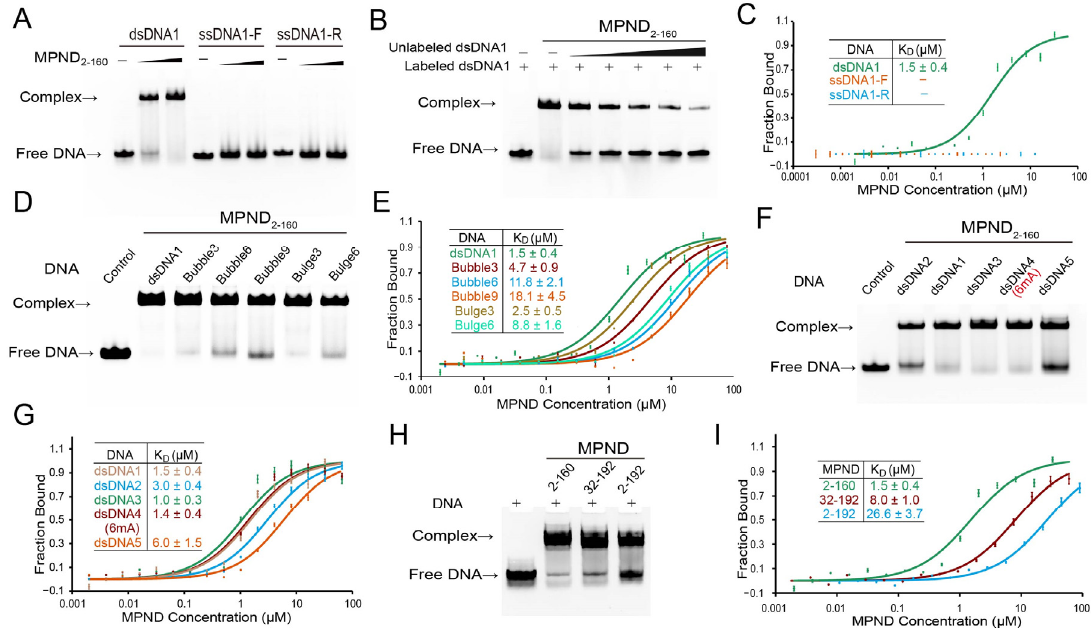
Figure 2. The binding of MPND to dsDNA. ( A ) The EMSA of MPND with dsDNA and ssDNA. Arrows indicate the positions of free DNA or protein-binding DNA. ( B ) EMSA showed that the binding of MPND with FAM-labeled dsDNA1 was reduced by the unlabeled DNA. The EMSA assay was detected by the fluorescence of FAM. ( C ) MST measurement of the binding affinity of MPND with DNA. ( D ) The MPND bound to general dsDNA or bubble/bulge DNA containing different amounts of mismatched bases in the middle of dsDNA. ( E ) MST determined the binding affinity of MPND to general dsDNA or the bubble/bulge DNA containing different numbers of mismatched bases in the middle of dsDNA. ( F ) The EMSA of MPND bound to dsDNA with different lengths or with 6mA modification. ( G ) The measurement of the binding affinity of MPND with dsDNA of different lengths or 6mA modification by MST. ( H ) The EMSA of different MPND trun ‐ cates with the dsDNA. ( I ) The measurement of the binding affinity of MPND truncates with dsDNA by MST. These experiments were all repeated three times.